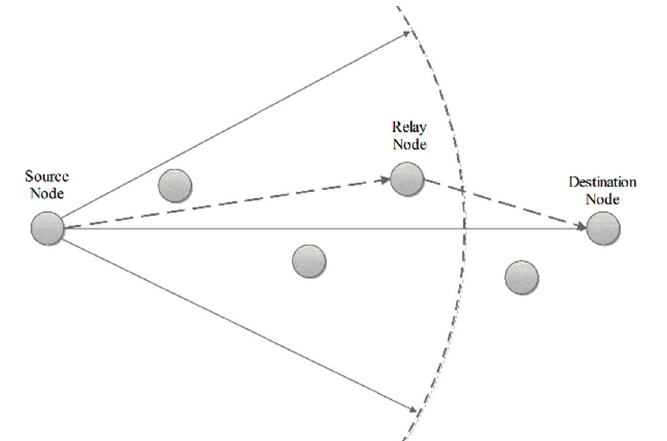
Figure 7. The cluster head routing phase.